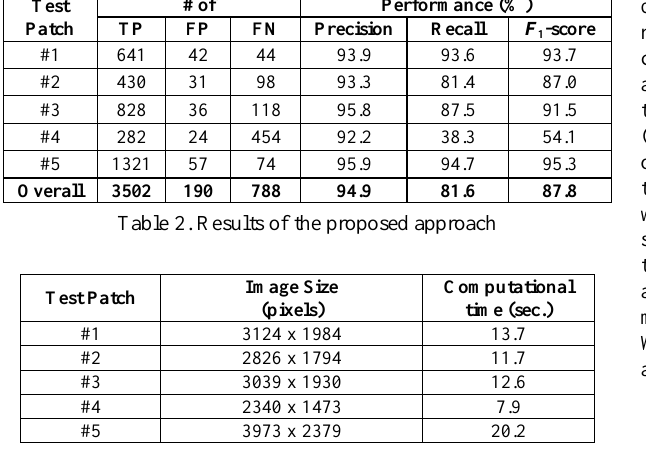
Table 3. Computational time elapsed by the proposed approach. planted trees could be detected. Bearing in mind the problem occurring for the young trees, the results of other test patches prove that proposed approach is generic for different planting forms and has the ability to detect citrus trees in dense patterns. For example, only 74 out of 1395 citrus trees are missed in a difficult case in patch #5; as a result, the proposed approach reaches a recall performance of nearly